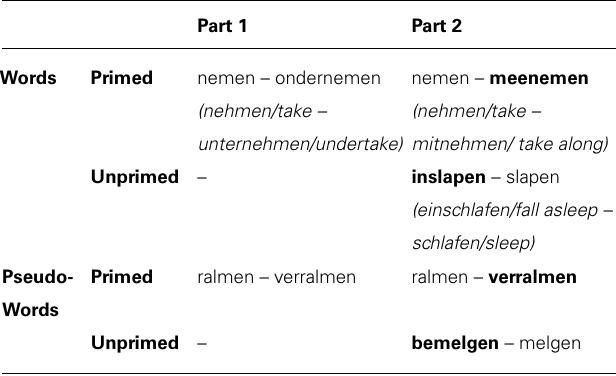
Table 1 | Design.Triple priming vs. no